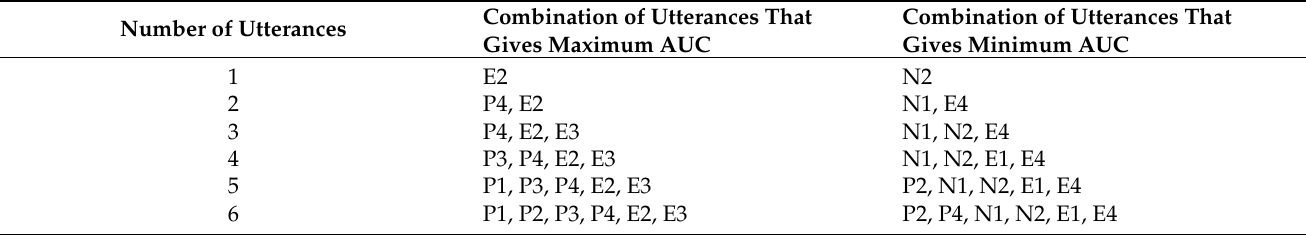
Table 3. Combinations of utterances that gave the maximum/minimum AUC for each number of utterances (up to six